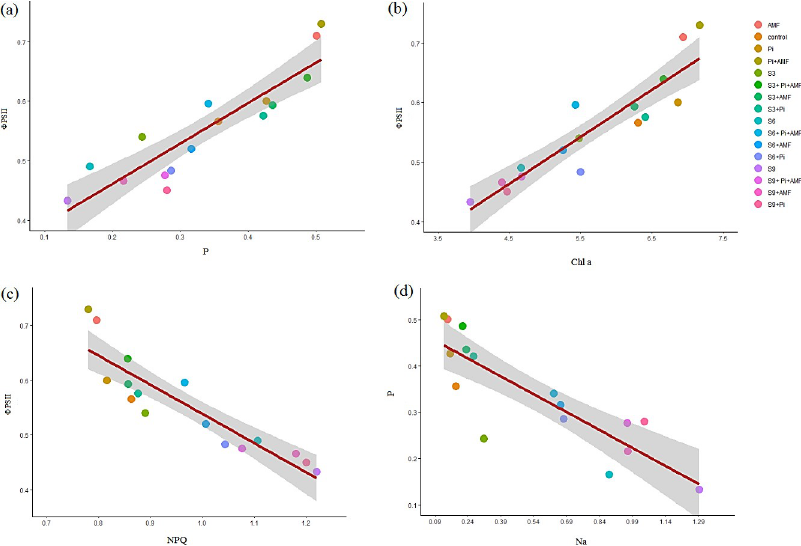
Fig 13. Relationship between some physiological parameters in inoculated and non-inoculated peppermint with ( P . indica , AMF and co-inoculation) under salinity stress in peppermint plant. AMF–Mycorrhizae treatment; AMF � P . indica –Mycorrhizae and P . indica